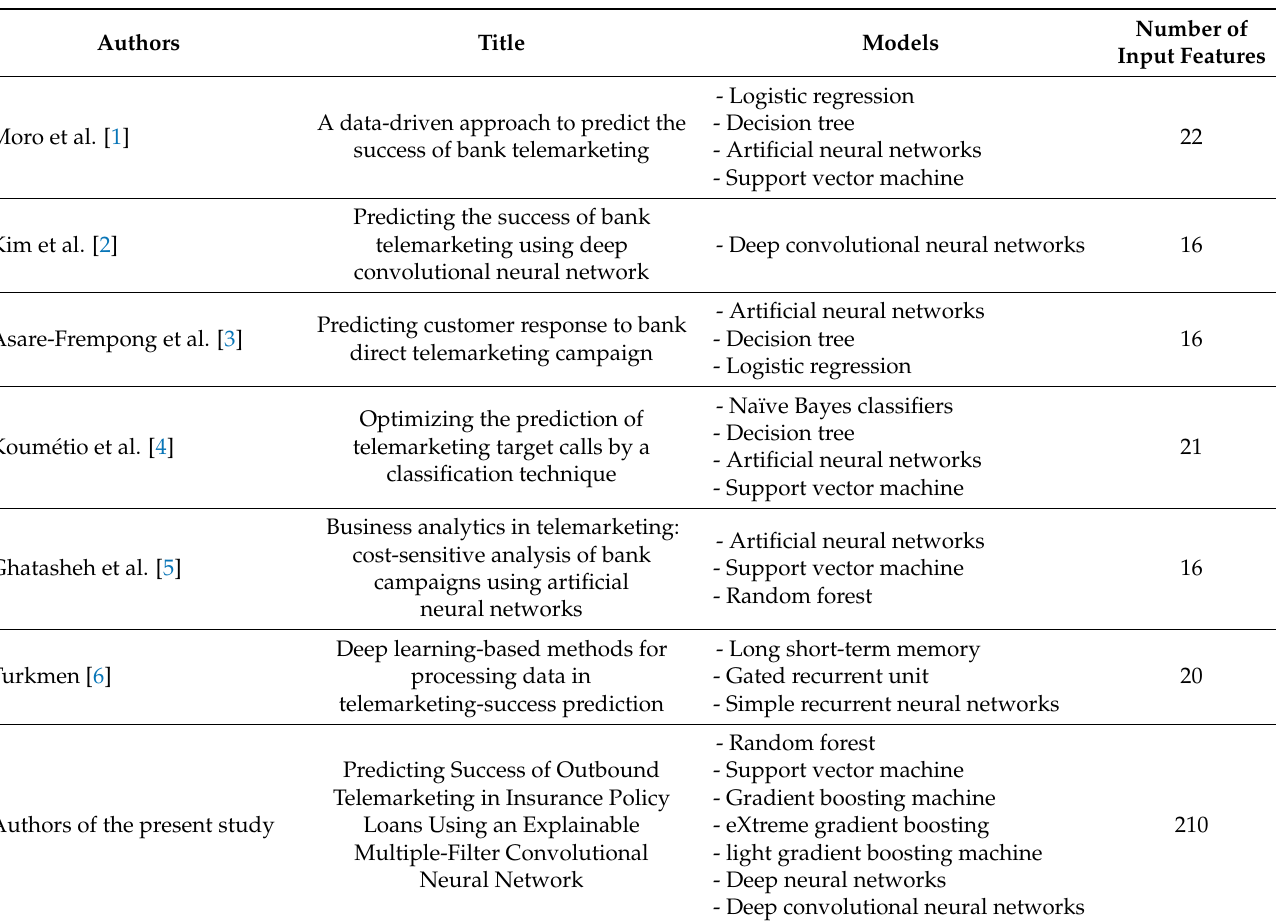
Table 1. Comparison of present work with previous studies on predicting telemarketing